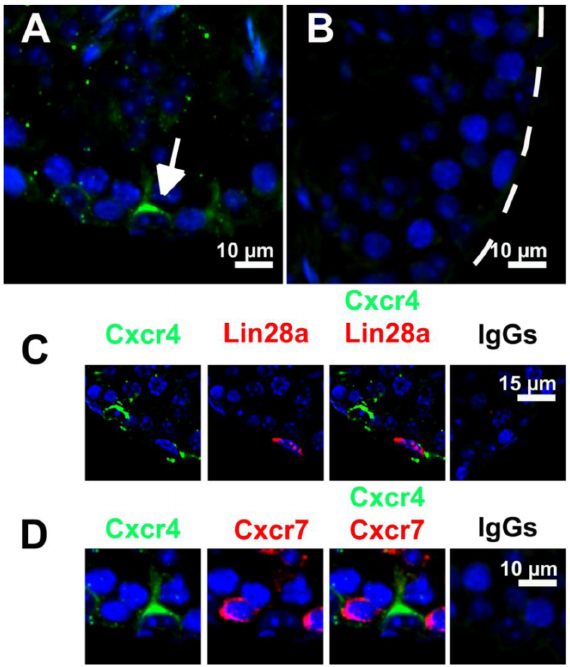
Figure 2. Cxcr4 and Cxcr7 expression in adult mouse testes. Representative images show immunofluorescence staining for Cxcr4 (green, A) in adult mouse testes. Cxcr4 is expressed by testicular cells at the basement membrane (arrow) of seminiferous tubules (indicated by dotted lines). Co-stainings revealed no Cxcr4 expression in Lin28a-positive (C) and Cxcr7-positive (D) spermatogonia. Incubation with corresponding IgG antibodies was used as negative control (B, C and D right column). All sections were counterstained with Hoechst (blue). Scale bars represent 10 and 15 m m, respectively.